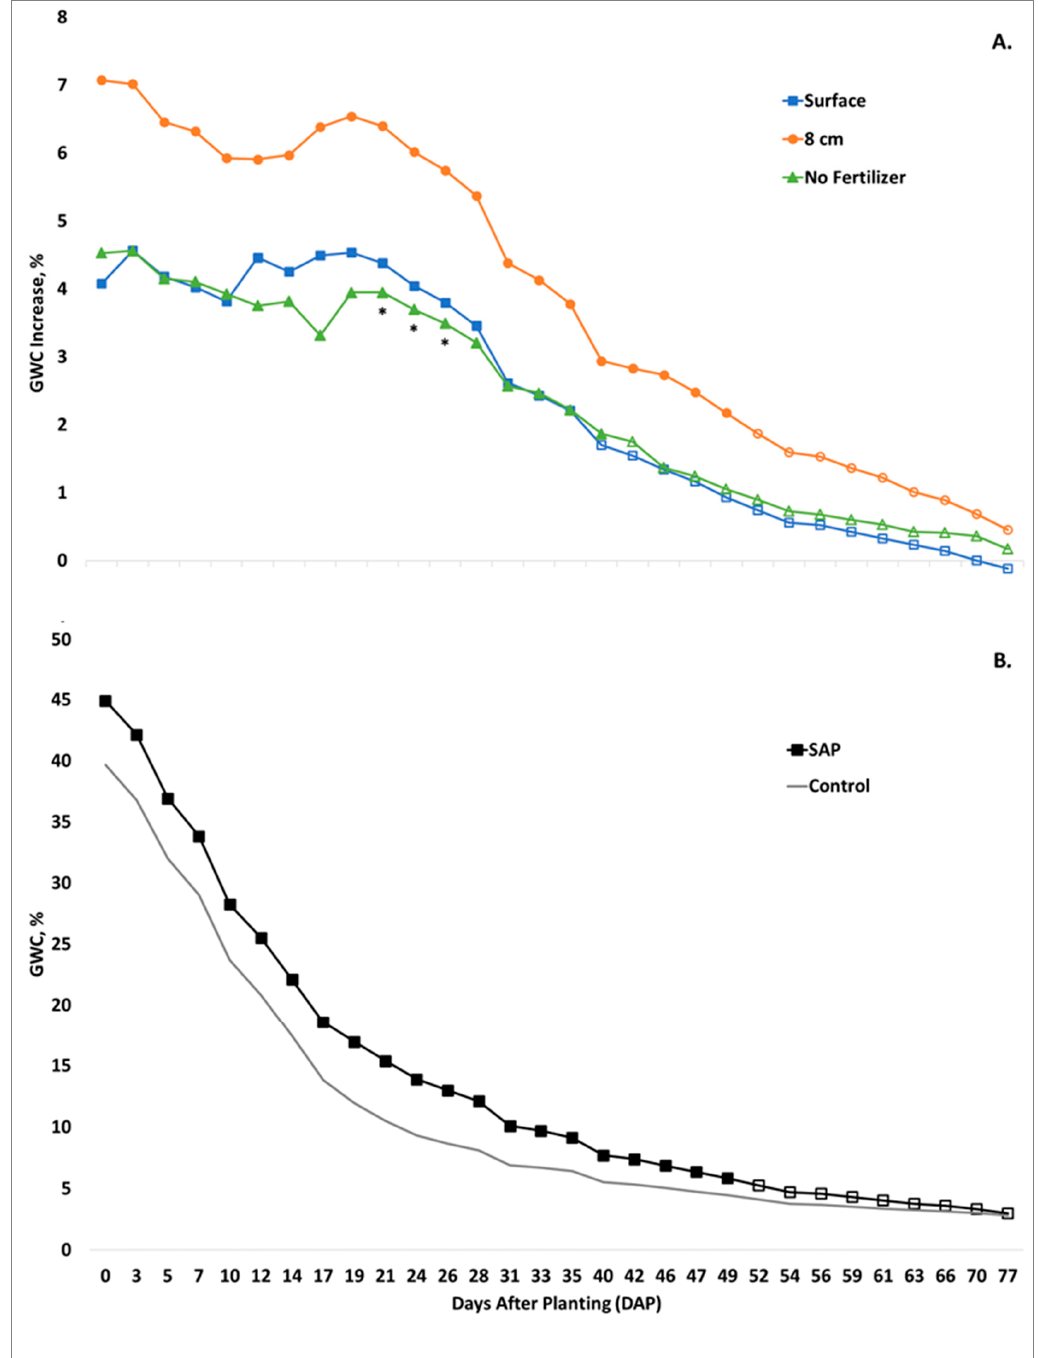
Figure 9. Gravimetric water content (GWC) for a superabsorbent polymer (SAP) fertilizer glasshouse study with bottlebrush squirreltail and Siberian wheatgrass (data averaged across species). ( A ) Increase in GWC with SAP (compared to the control without SAP) for fertilizer applied at the: Surface, 8 cm below the surface, or No Fertilizer. Filled markers indicate significance compared to the control (no SAP) for each fertilizer treatment ( p < 0.0001). The symbol “*” indicates days where No Fertilizer was statistically less than with fertilizer applied at 8 cm depth ( p = 0.05). ( B ) The GWC with or without SAP. Data are averaged across fertilizer treatments. Filled markers on the SAP line indicate significance compared to the control ( p <